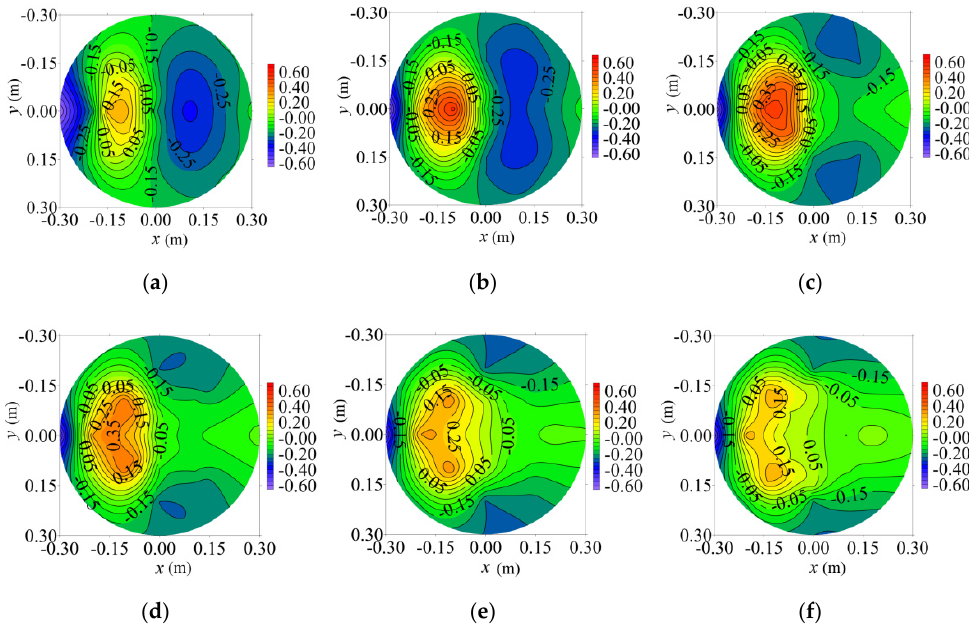
Figure 20. Contour maps of the maximum vertical wind velocity ( L = 0.5 D jet , r h = 1.0 D jet ): ( a ) H / h = 1/12; ( b ) H / h = 1/6; ( c ) H / h = 1/4; ( d ) H / h = 1/3; ( e ) H / h = 5/12; ( f ) H / h = 1/2.